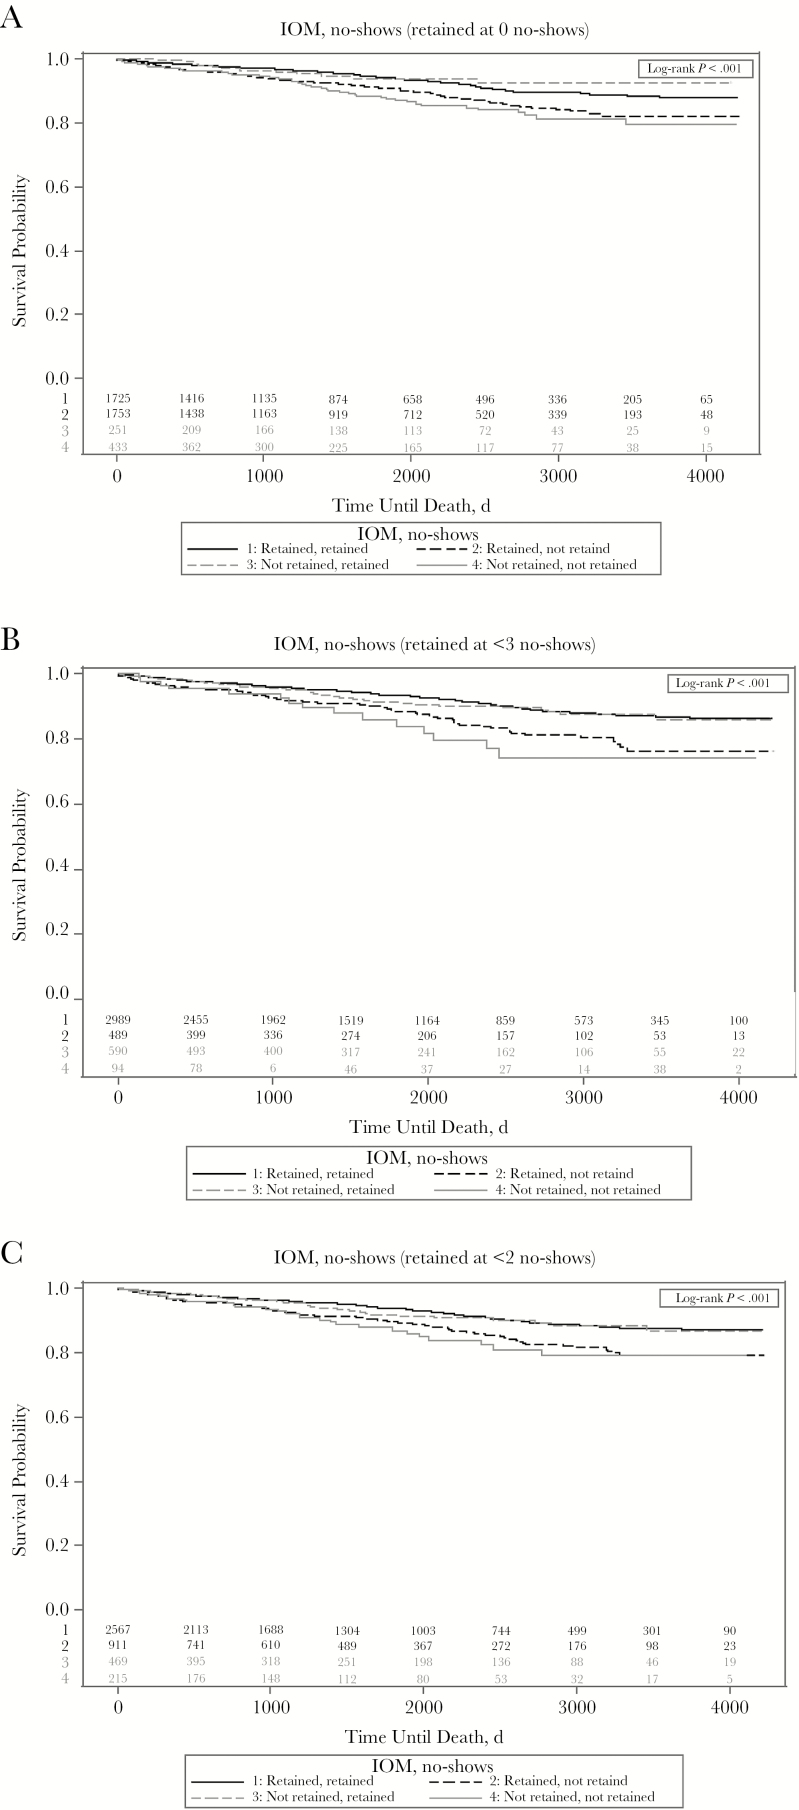
Kaplan–Meier survival curves for all-cause mortality among patients classified as retained or not retained 12 months after initiation of antiretroviral therapy according to Institute of Medicine (IOM) and missed-visits (no-show) indicators. (The IOM measure defines retention as having ≥2 kept [attended] primary care visits separated by ≥90 days during a 12-month period.) The number of patients at risk is shown above the x-axis. A, Retained defined as 0 no-shows. B, Retained defined as <3 no-shows. C, Retained defined as <2 no-shows.